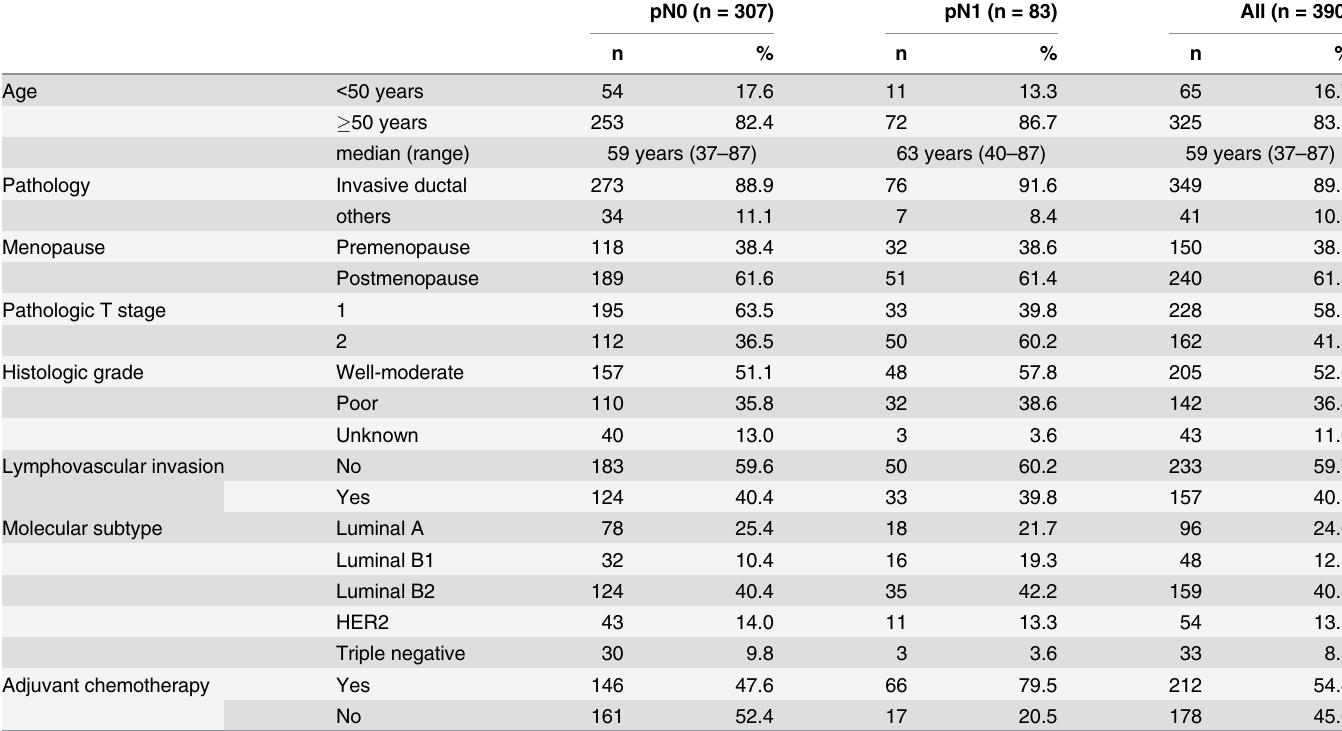
Table 1. Baseline characteristics.